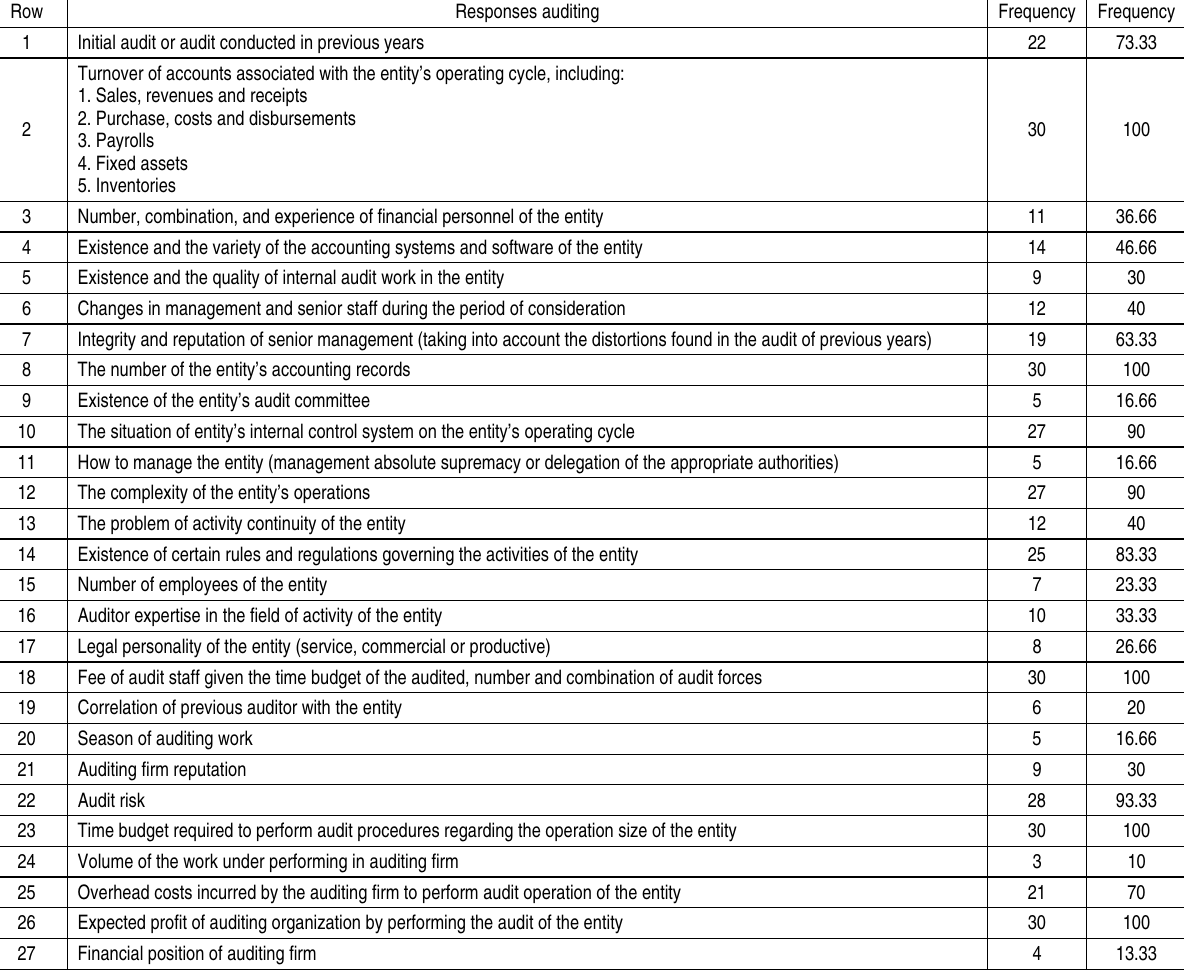
Table 2. Responses of audit institutions to the research question